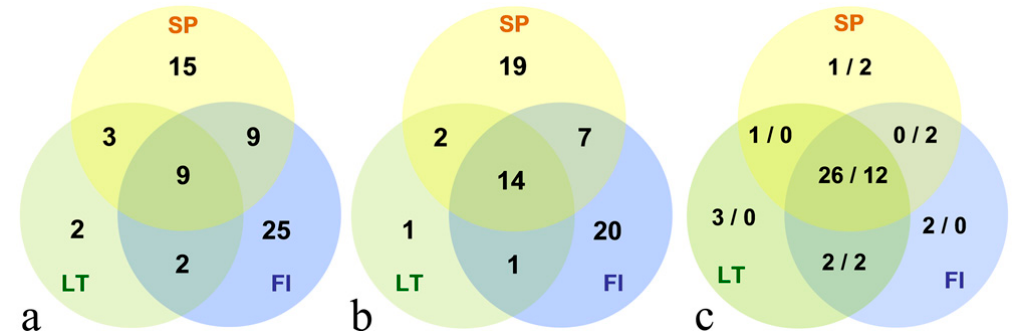
Figure 2. Quantitative distribution of differentially expressed protein spots identified by two-dimensional gel electrophoresis analysis of needle protein samples isolated from seedlings originating from the Spanish (SP), Finish (FI) and Lithuanian (LT) Scots pine populations. Number of differentially expressed protein spots between the populations under growth promoting conditions ( a ) and upon acclimation ( b ) is shown. Number of upregulated and downregulated protein spots upon acclimation treatment are indicated by numbers separated by slash ( c ). The portion of the cycles overlapping between two or all three populations indicate a number of protein spots that are differentially expressed between the two or among all three populations, respectively.